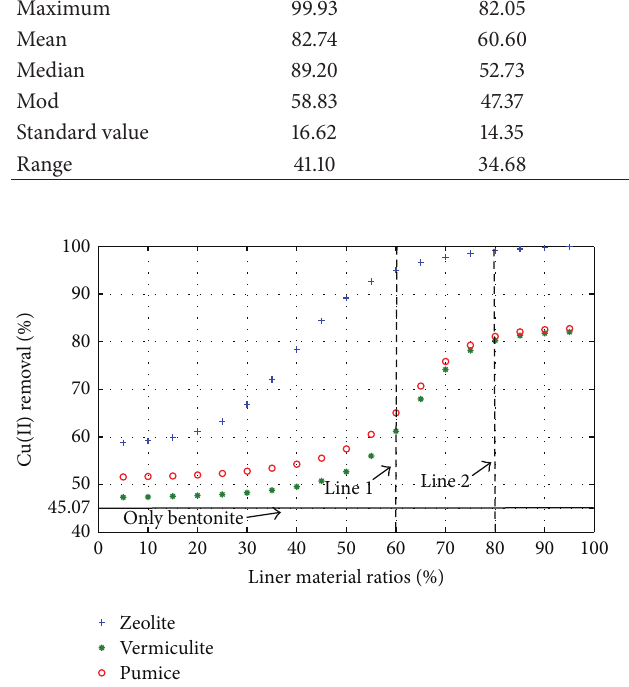
Figure2:PredictionofCu(II)removalwithdifferentlinermaterials.